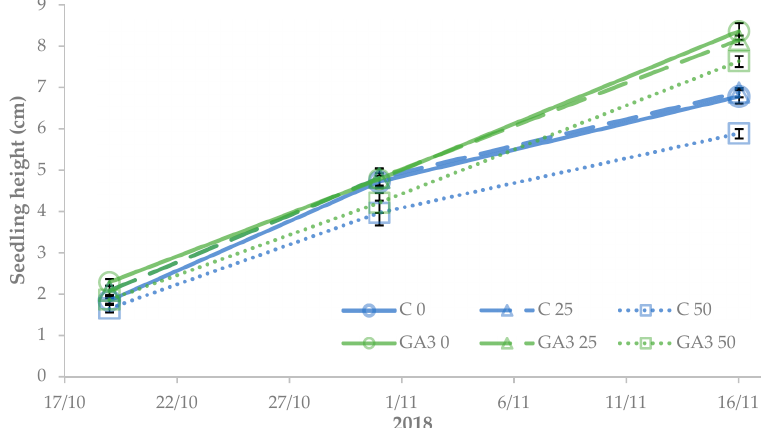
Figure 7. Effect of the seedling treatments (C, untreated control, GA, gibberellic acid spray 10 − 5 M) and salt stress (0, 25, and 50 mM NaCl) on sweet pepper seedling growth (the LSD value at p < 0.05 for 30/10 = 0.44 and for 16/11 = 0.80).